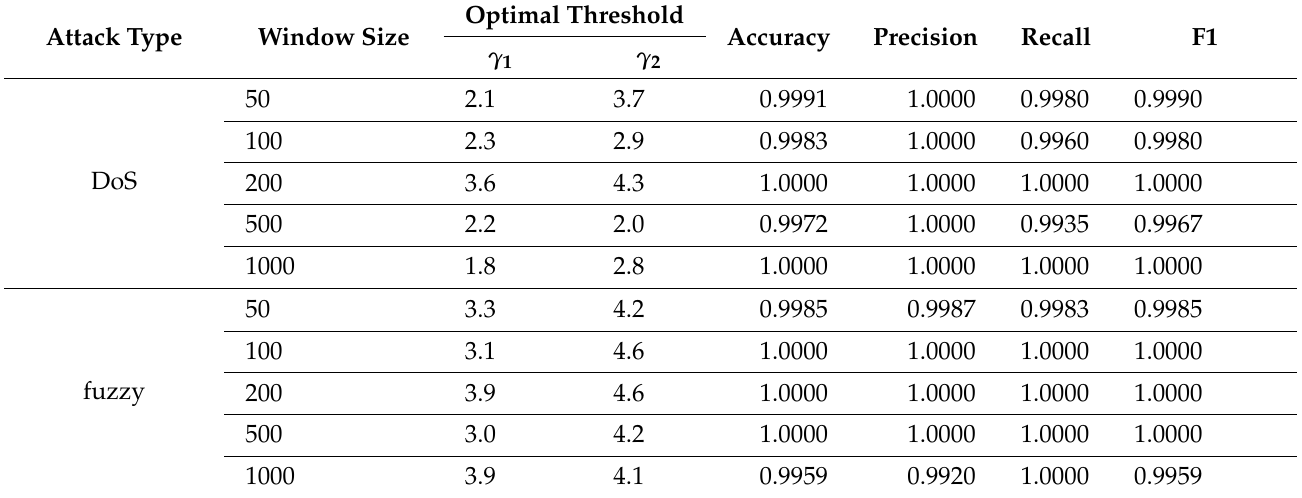
Table 15. Performance parameters for Soul.